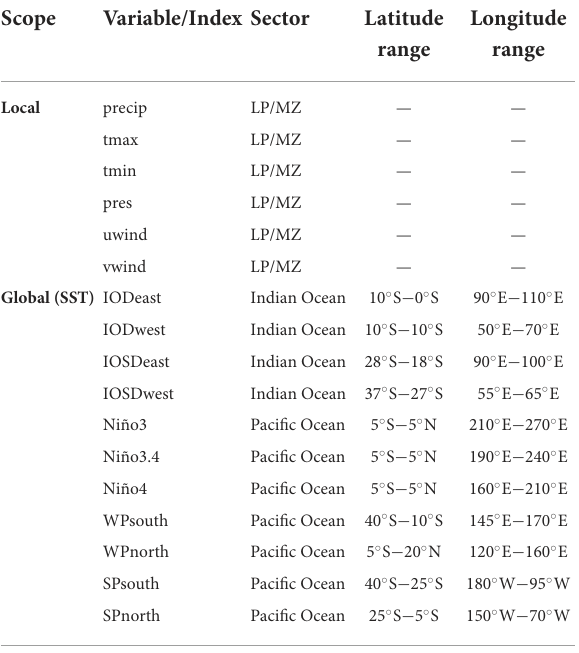
TABLE 2 Local and global climate predictors used to predict malaria incidence and their domains.